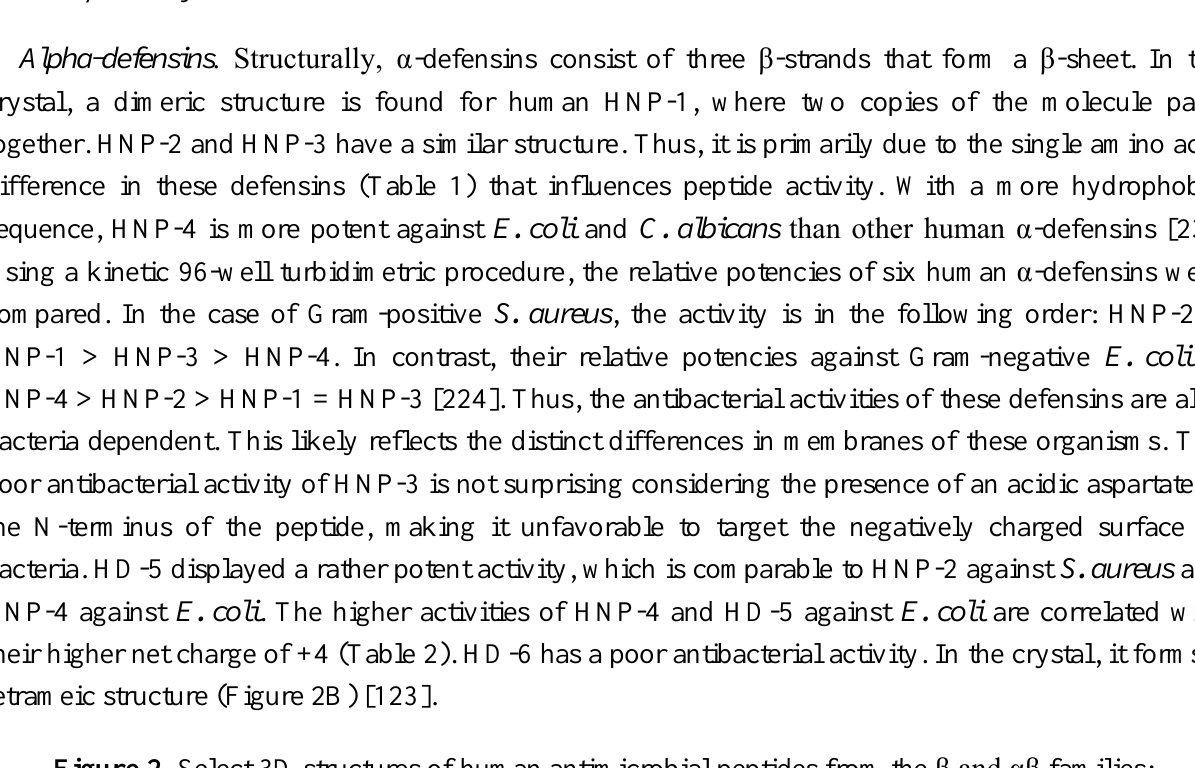
Figure 2. Select 3D structures of human antimicrobial peptides from the β and αβ families: ( A ) HNP-1 (dimeric crystal structure, PDB ID: 3GNY); ( B ) HD-6 (tetrameric crystal structure, PDB ID: 1ZMQ); ( C ) hBD-3 (NMR structure, PDB ID: 1KJ6) and RegIIIα (crystal structure, PDB ID: 4MTH). See the text for further